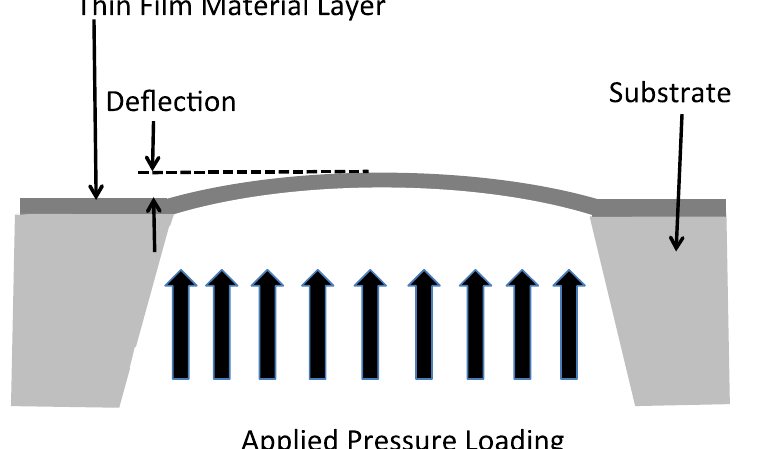
Figure 14. Bulge test structure.